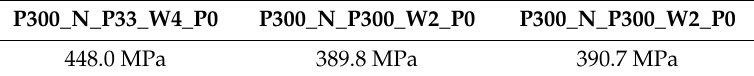
Table 3 . Best mechanical results obtained in study [34].